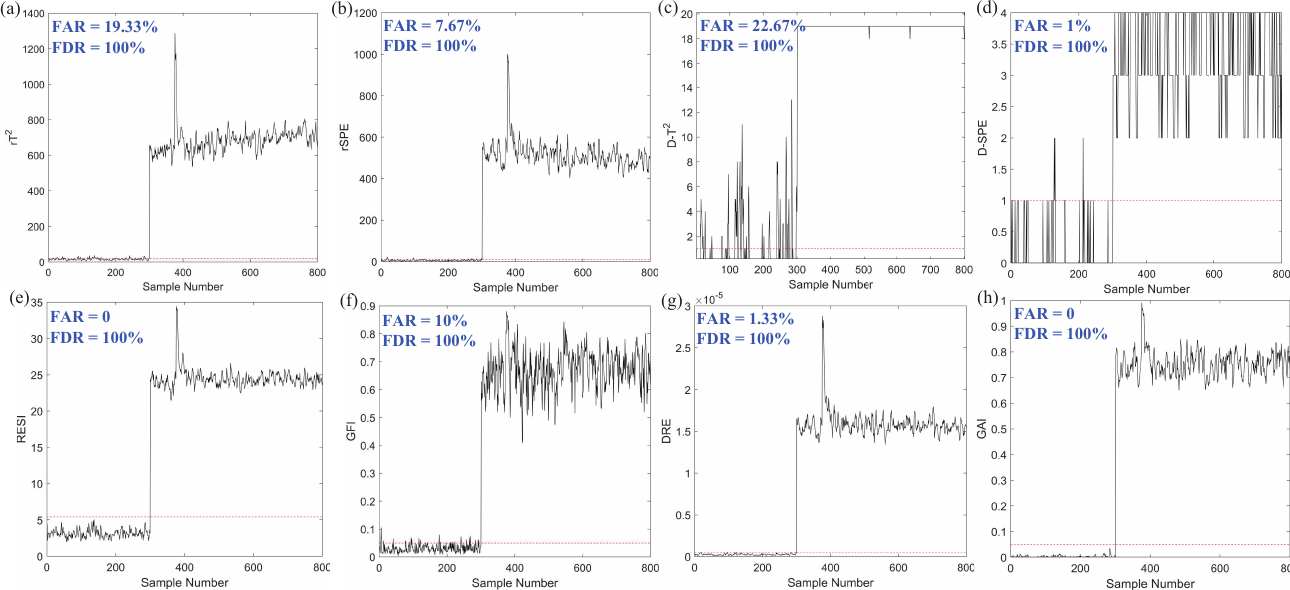
Figure 14. The process monitoring results of anode slippage in aluminum electrolysis